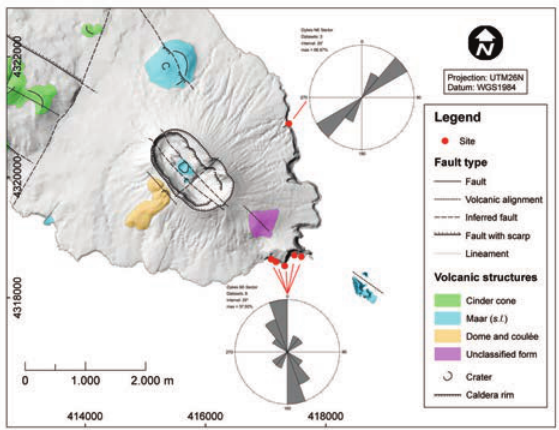
Figure 13. Spatial variations of dyke directions around Caldeira Vol- cano (circular histograms of unweighted frequencies of dyke di- rections and dip angles). Topography from IGeoE